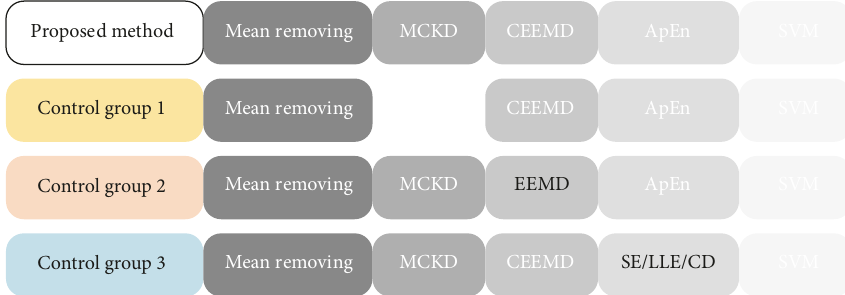
Figure 5: Methods